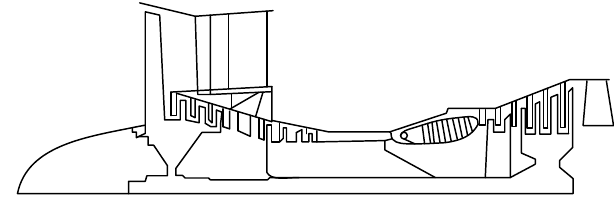
Figure 13. JT9D engine diagram.